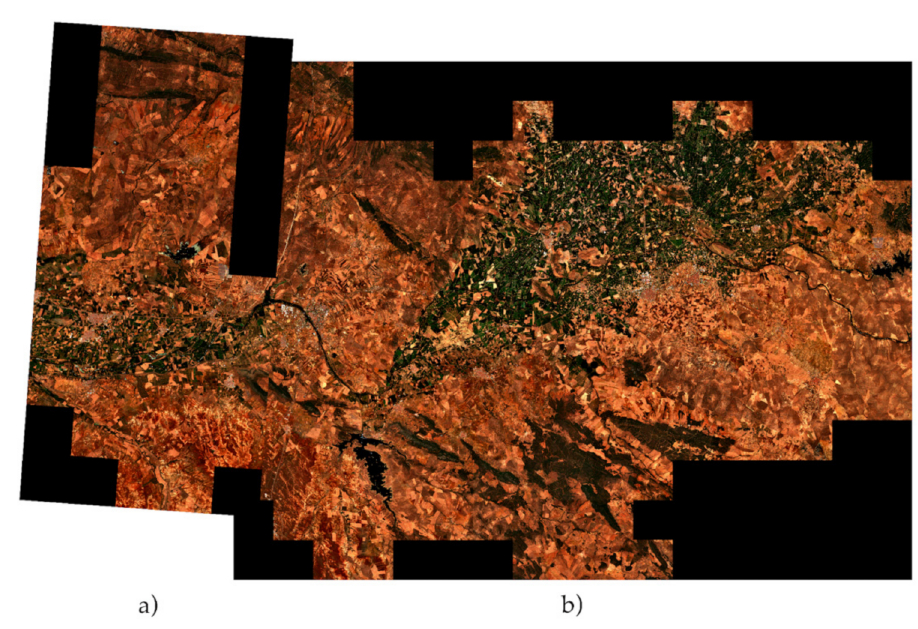
Figure 16. RGB of Zone 29 ( a ) and 30 ( b ). M é rida and Don Benito, Extremadura.